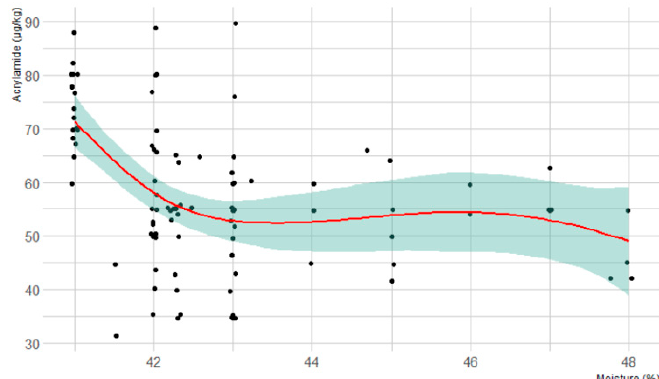
Figure 1. Curvilinear relationship between acrylamide levels and moisture content in refined flour bread and wholemeal bread and bread rolls (the light blue area indicates the 95 percent confidence interval).